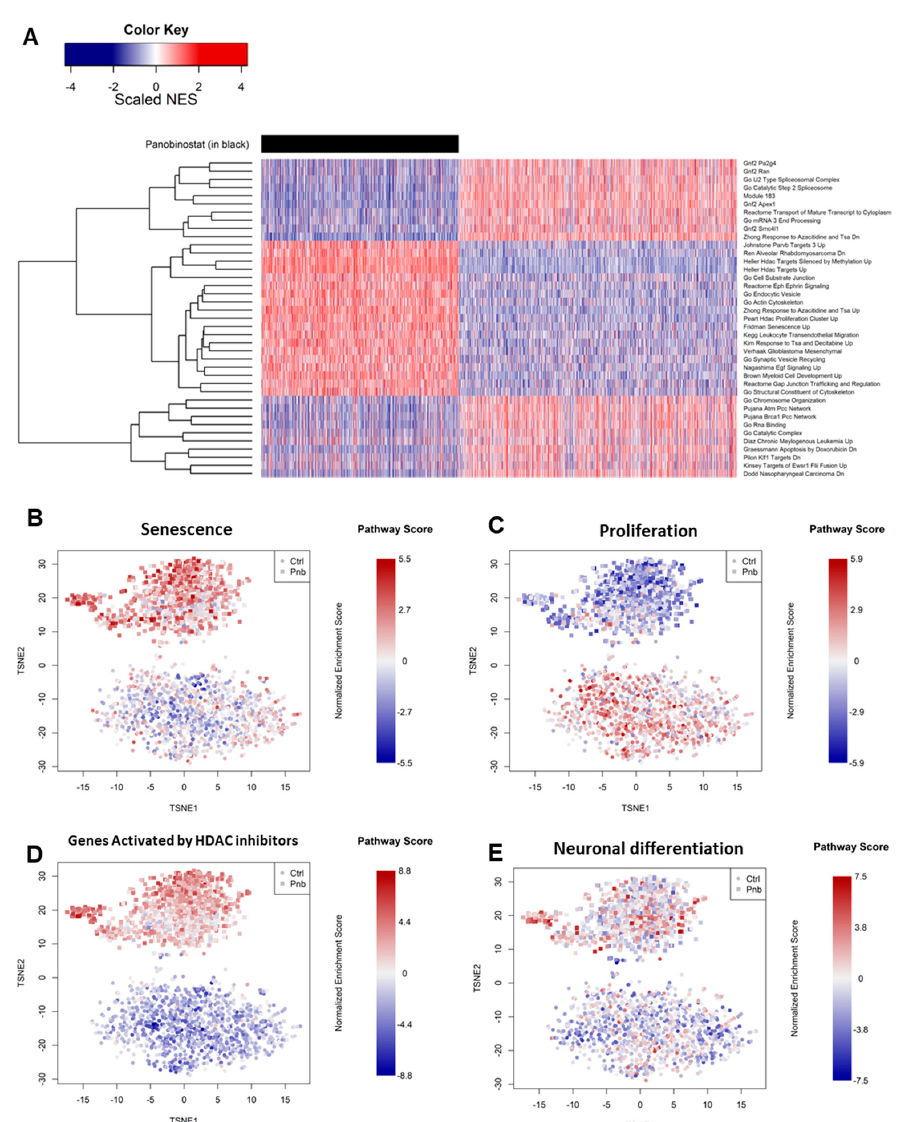
Figure 3. ( A ) Single-cell gene set enrichment analysis (GSEA) reporting the relative normalized enrichment scores (NESs) for pathways (rows) in cells (columns). Cells treated with PNB are grouped to the left and marked in black. Pathways reported are those that most significantly changed in the PNB-treated vs. control contrast. ( B – E ) Single-cell gene set enrichment analysis taset of control (ctrl) and panobinostat-treated (pnb) cells. The selected pathways were defined by the MSigDB database [31] (see Section